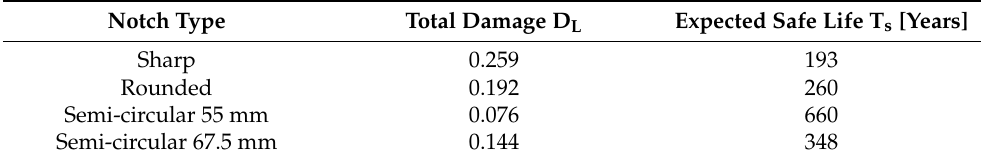
Table 10. Total damage and expected safe